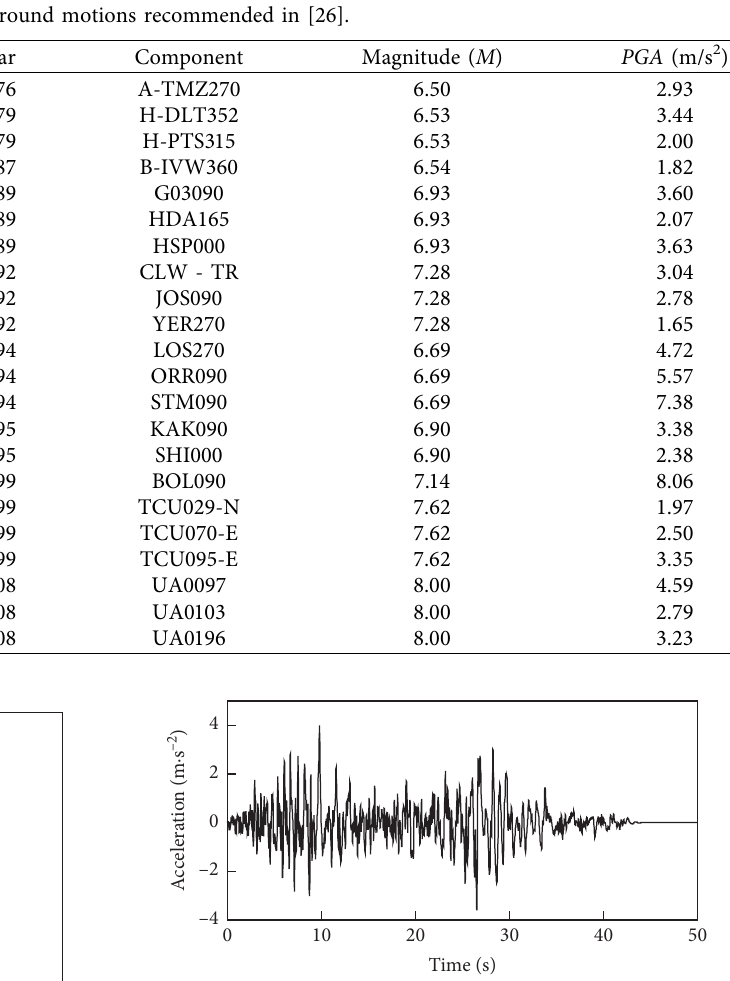
Figure 7: Acceleration time-history curve for